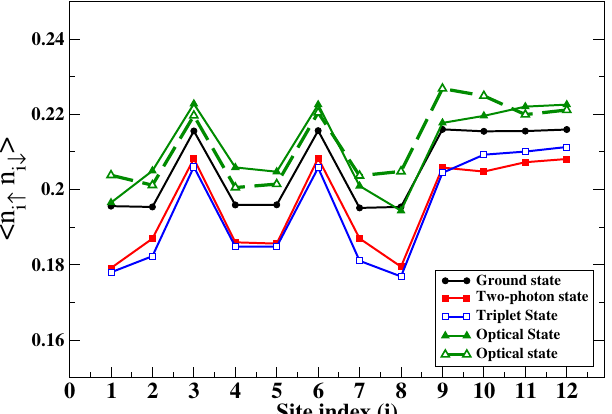
Figure 3. (Color online) The probability of double occupancy of C-atoms by electrons plotted against the site index (see Figure 2) for coronene. Sites related by C 2 symmetry are perfectly equivalent, and hence, are not shown. Lines are guides to the eye only. The two different plots for the optical states correspond to the two nearly degenerate